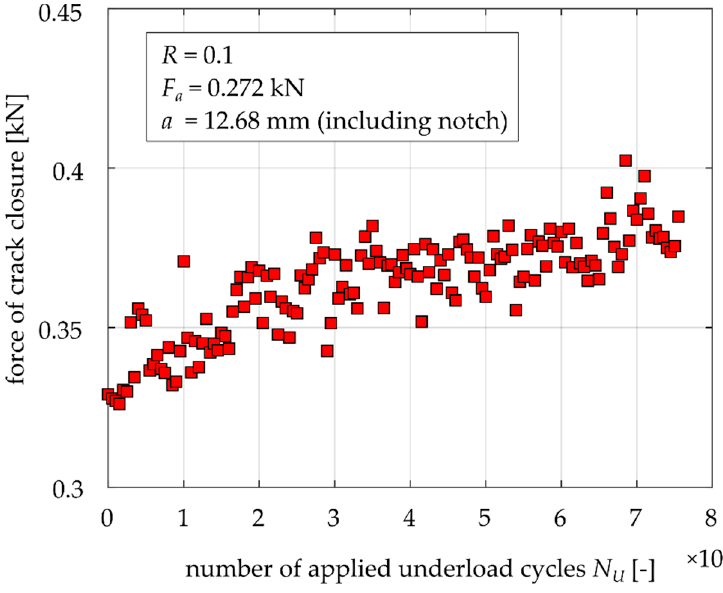
Figure 19. Experimental results of crack closure as function of underload cycles.